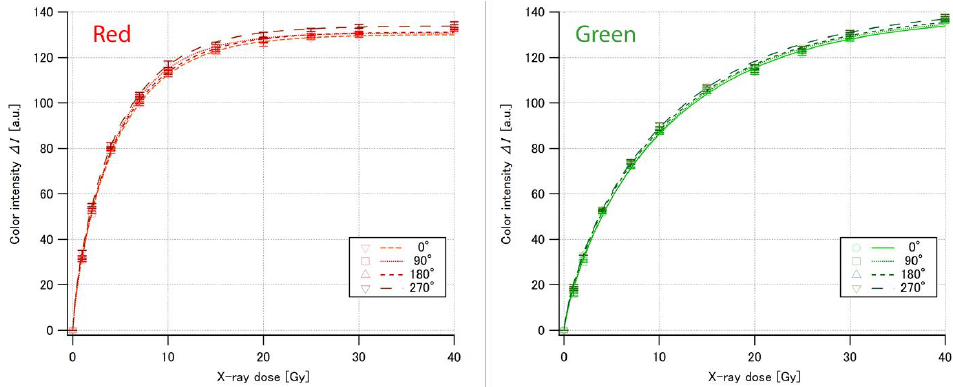
Figure 5. Dose dependence of the color intensities (( left ): red component, ( right ): green component) of EBT-XD irradiated with 160 kV X-rays at up to 40 Gy and measured with Nix at four angles: 0°, 90°, 180° and 270°.